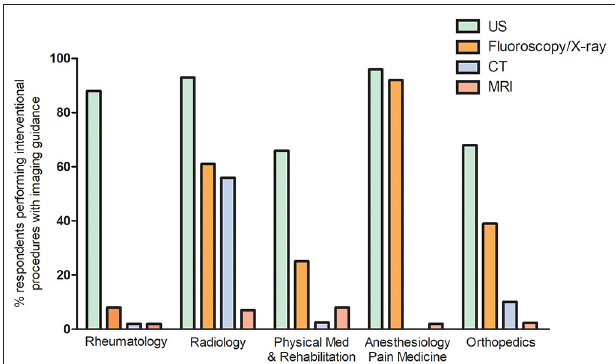
FIGURE 1 | Percentage of respondents using ultrasonography, X-ray/fluoroscopy, computed tomography or magnetic resonance imaging to guide interventional procedures, divided by specialty. This question was answered only by respondents stating that they performed imaging guided procedures. The 5 specialties with the highest numbers of respondents are